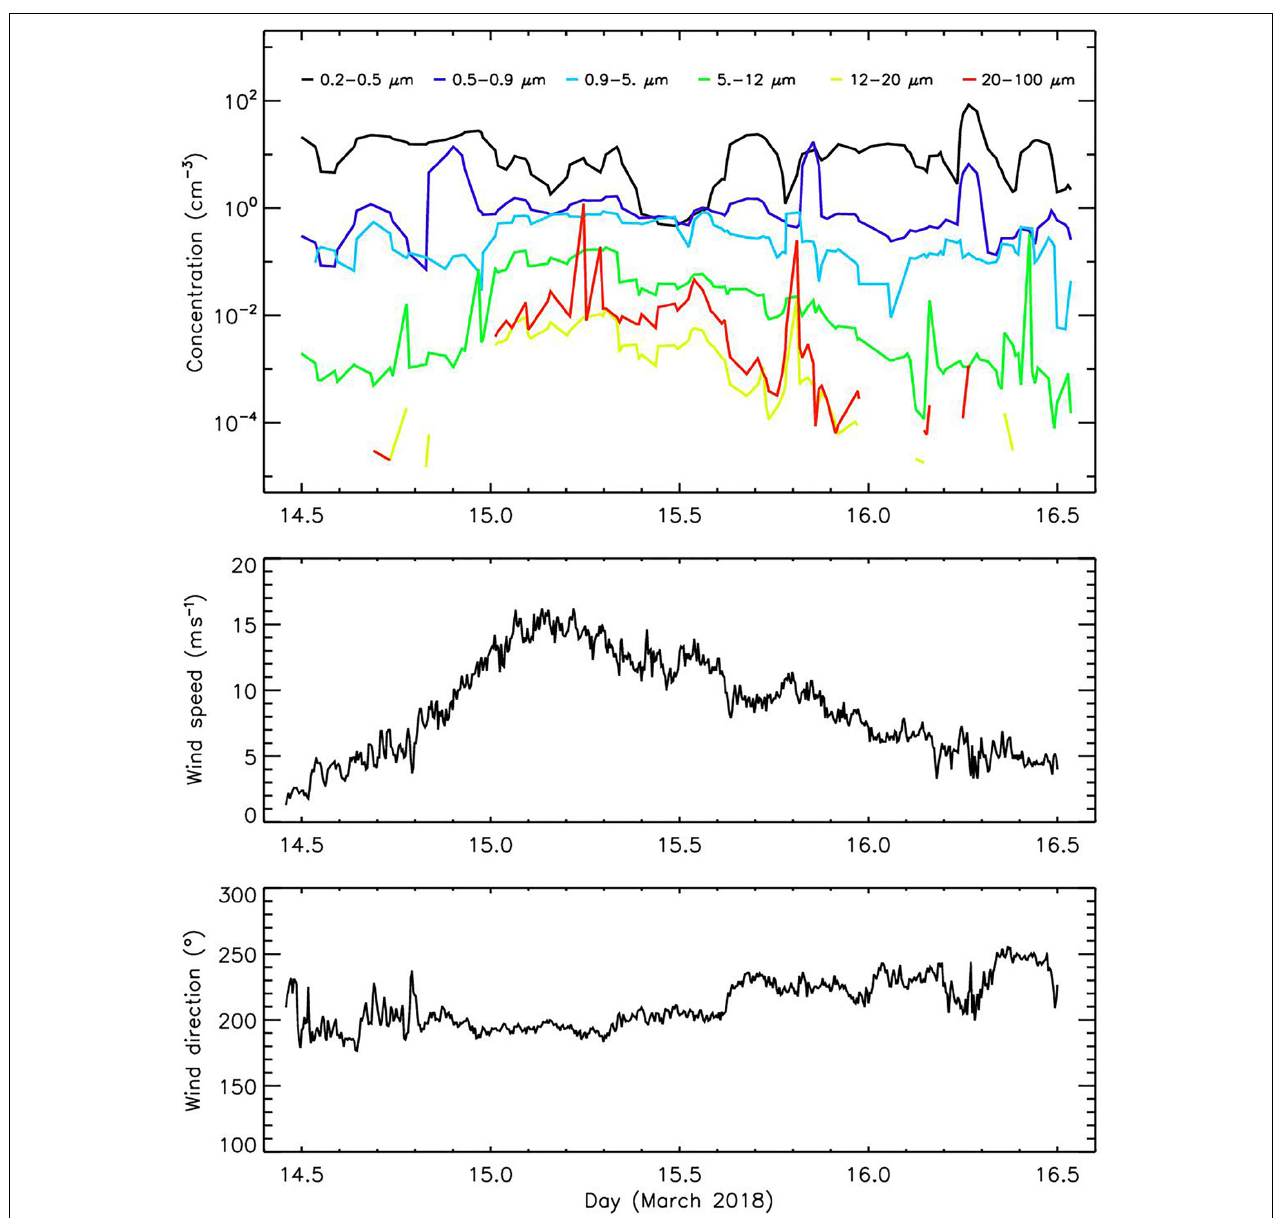
FIGURE 11 | Event 2 – wind conditions and aerosol